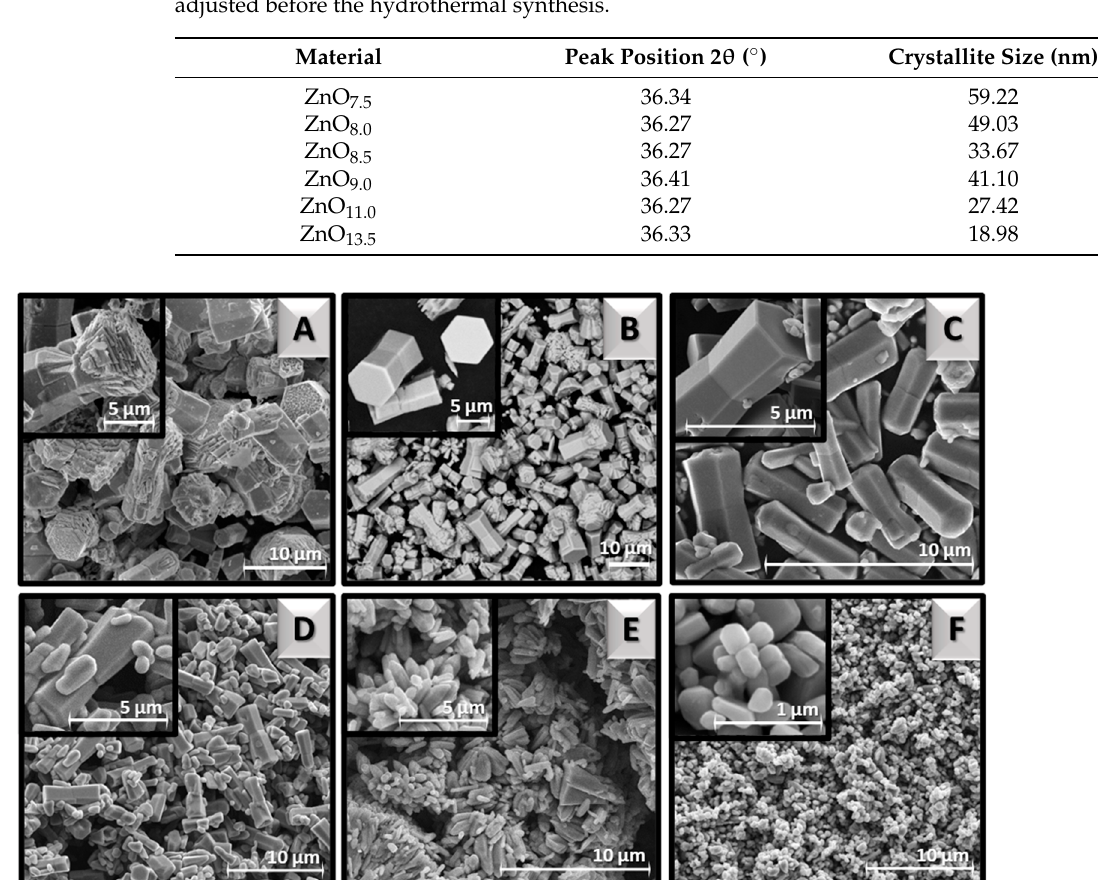
Table 4. ZnO x crystallites sizes estimated via Scherrer’s equation. Subscript x corresponds to the pH adjusted before the hydrothermal synthesis.